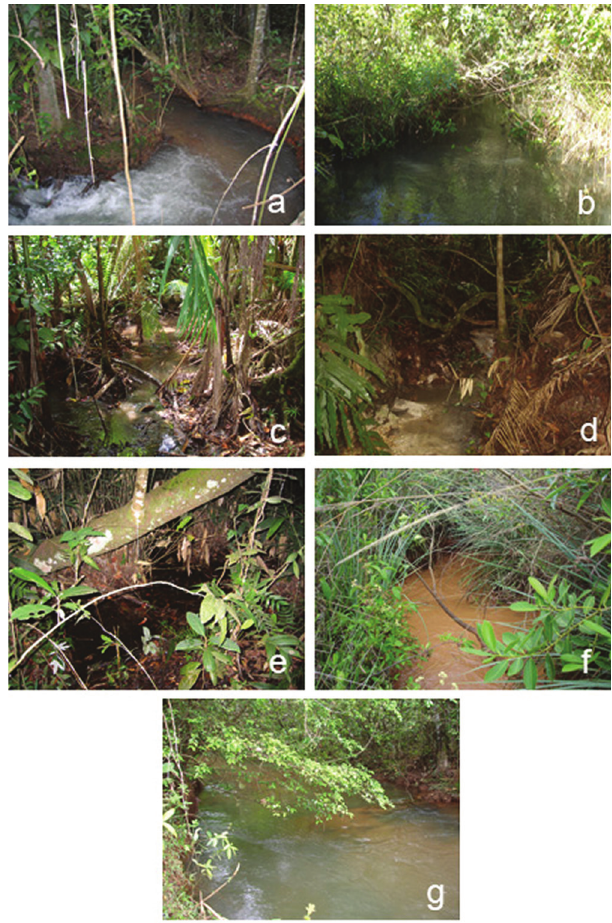
Fig. 2. General view of sites 1 to 7 sampled at the Bananal stream subbasin, Paranoá Lake basin,